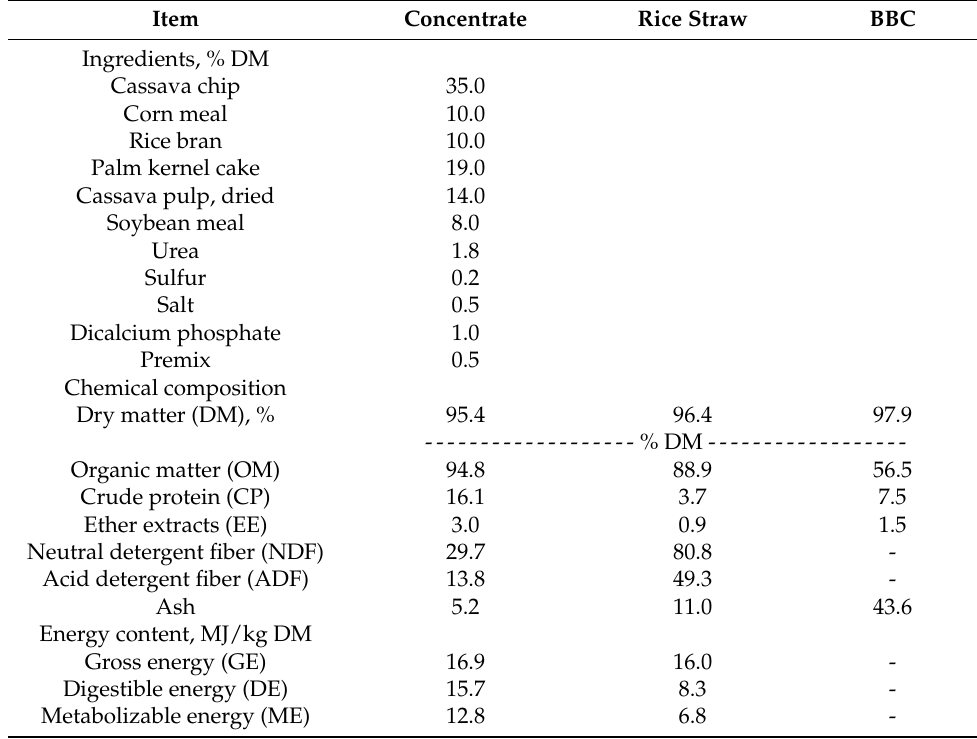
Table 1. The ingredients in the concentrate and the chemical composition of the concentrate, rice straw, and BBC used in the